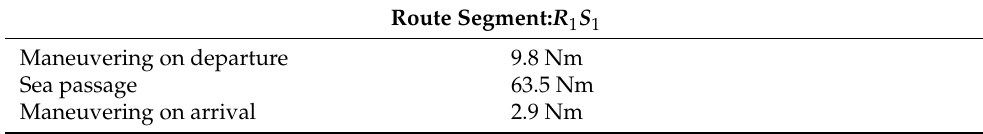
Table 6. Distances traveled in the specific navigation mode on the route segment R 1 S 1 .